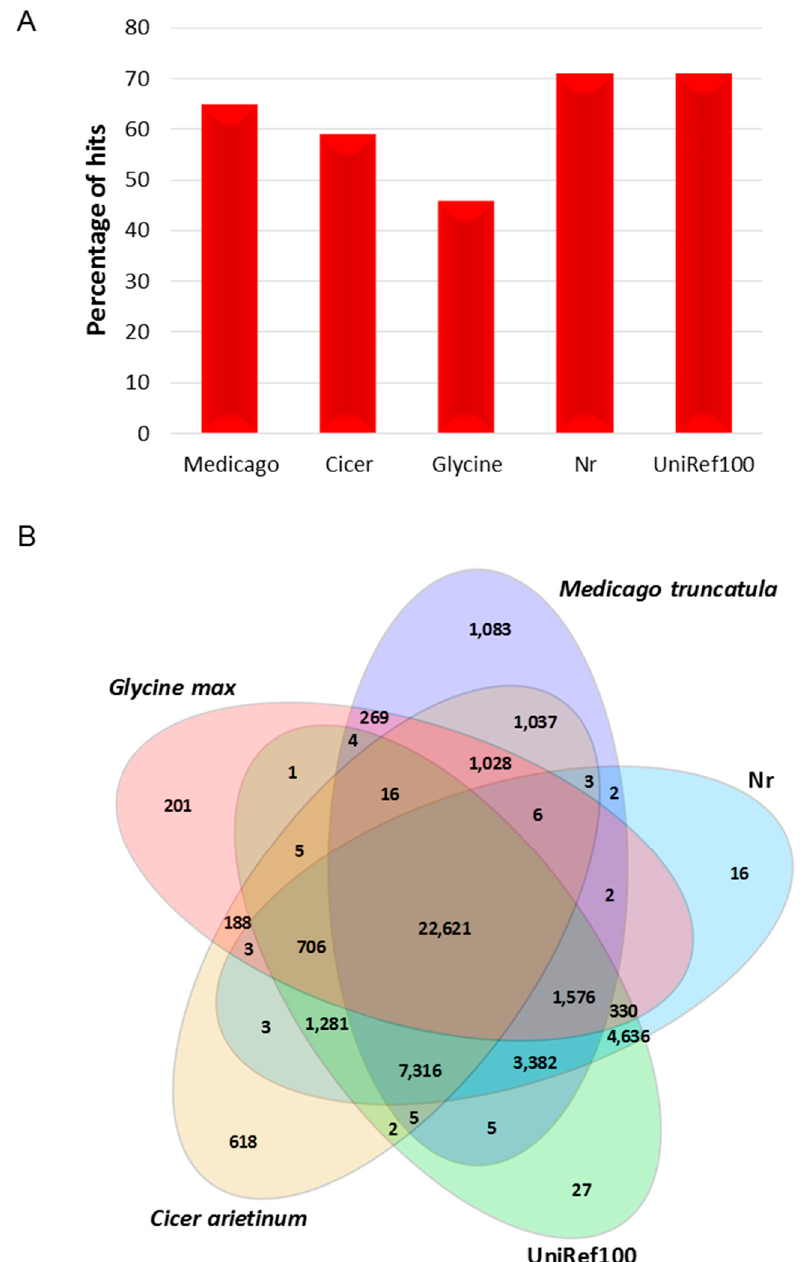
Figure 1. Sequence conservation of the Cassab-derived reference unigene transcriptome in comparison to sequences from other species: ( A ) percentage of sequence similarity of Cassab-derived reference transcripts with sequences from other plant species in the Nr and UniRef100 databases; ( B ) Venn diagram summarising the distribution of BLAST matches between the Cassab-derived reference unigene transcriptome and sequences from three other legume genomes and two databases. Numbers within the Venn diagram indicate the number of sequences sharing similarity using BLAST.